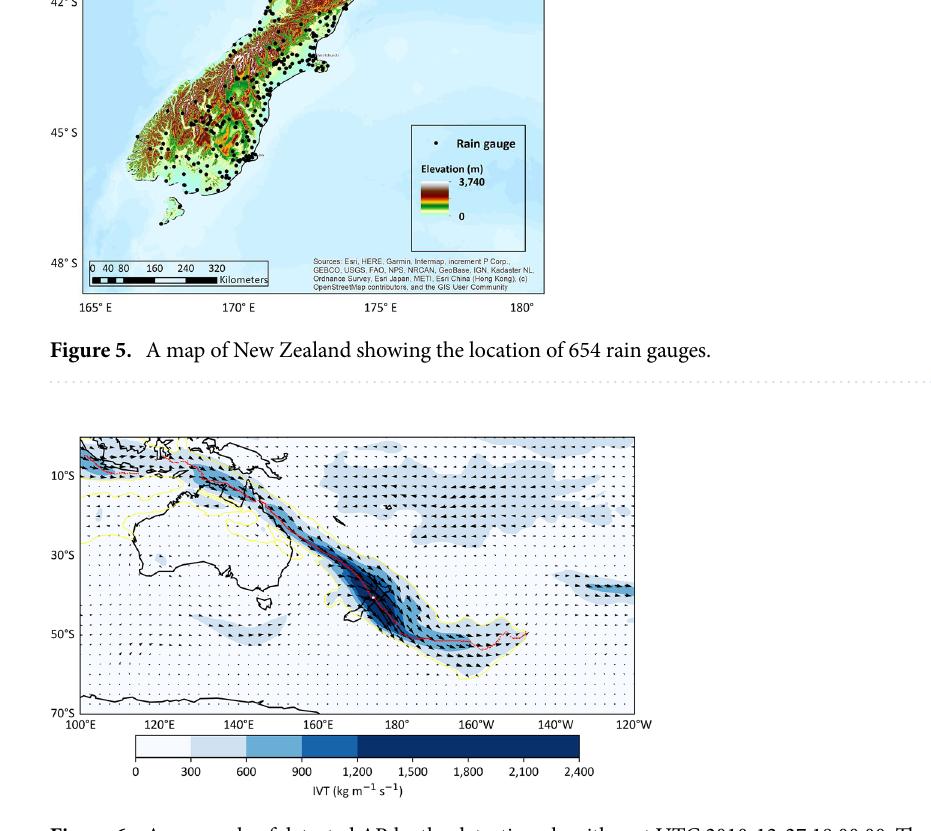
Figure 6. An example of detected AR by the detection algorithm at UTC 2010-12-27 18:00:00. The outputs of the algorithm include the shape boundary (yellow), axis (red), landfall location (white). Colour shading area and vectors refer to the AR IVT magnitude (kg m −1 s −1 ) and direction, respectively. This case was one of the strongest ARs between 1979 and 2018. The landfall location is at (174°E, 40.625°S) with the IVT magnitude of 2176 kg m −1 s −1 and 145° direction. The mean AR IVT magnitude and direction is 397 kg m −1 s −1 and 123°, respectively. The length and width is 13,236 km and 1216 km,